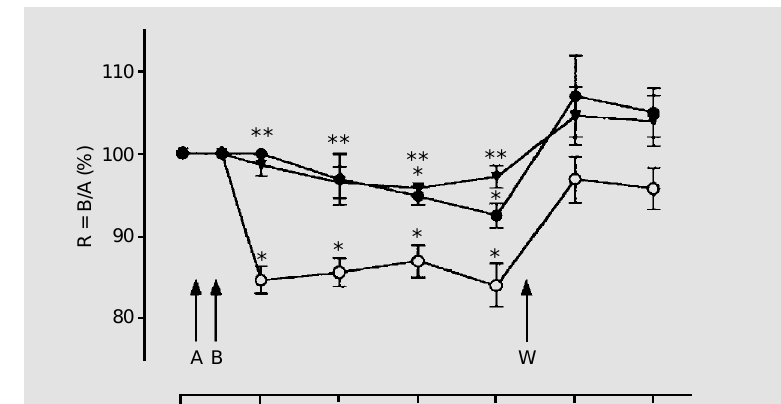
Figure 1 - Percent increase of amplitude of muscular contrac- tion (AMC) induced by L-arginine (L-Arg, 9.4 mM) in the absence or presence of 25 and 50 nM hemoglobin (Hb) in neuromus- cular preparations indirectly stimulated at 0.2 Hz. The height of the column represents mean (± SEM) of 5 to 6 experiments. *P<0.05 compared to control (ANOVA). **P<0.05 compared to 25 nM Hb (Bonferroni post hoc test).